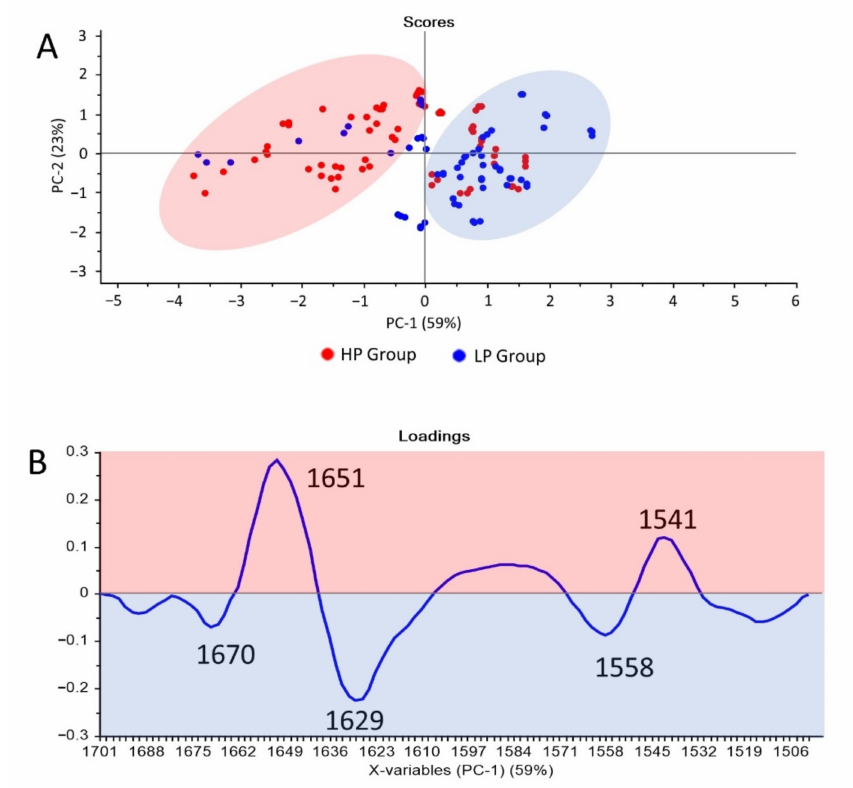
Figure 5. PCA analysis of the 1700–1500 cm − 1 FTIR exosome spectral range. PCA score plots ( A ) and PCA loading plots ( B ). PCA score plots showed distinct clustering between the LP (blue box) and HP groups (pink box). PCA loading plots identify specific important peaks for the LP and HP